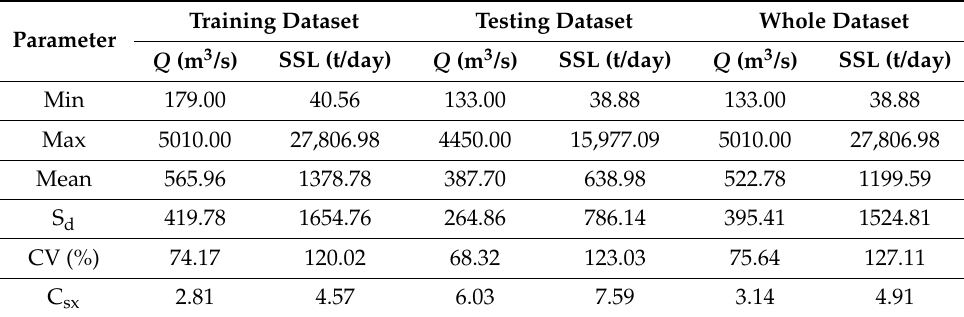
Table 2. Statistical analysis of the Magdeburg-Strombrücke gauging station